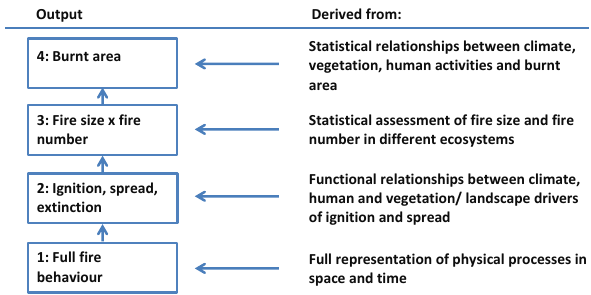
Figure 2. Summary of the levels of model complexity required to derive different aspects of global fire regimes. Outputs from mod- els functioning at level 1 can be used to derive higher-level outputs, but it is not possible to work backwards (i.e. empirical relationships between burnt area and environmental drivers will not allow for as- sessment of changes in fire number and fire size). Currently there are fire routines in global DGVMs that represent all of these levels of complexity (see Table